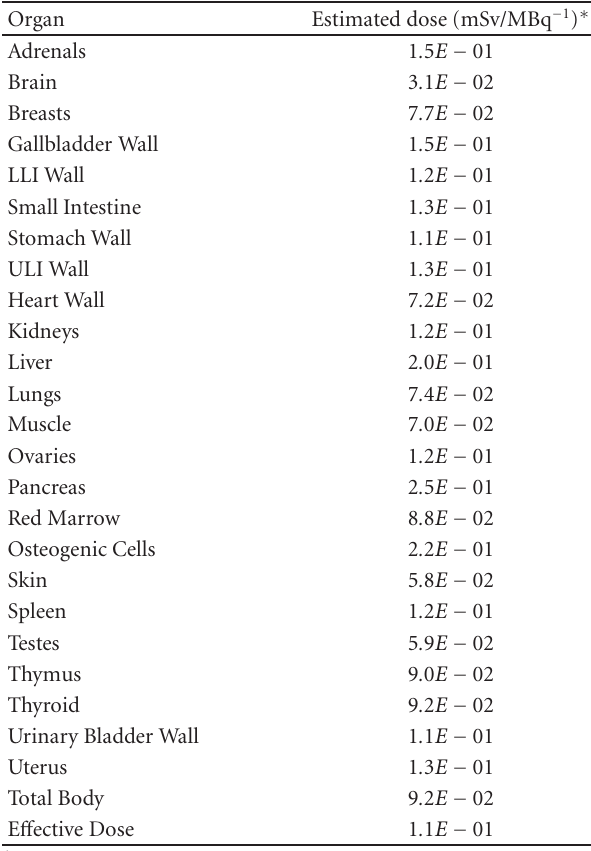
Table 3: Radiation dose estimates for 111 In-AMBA in